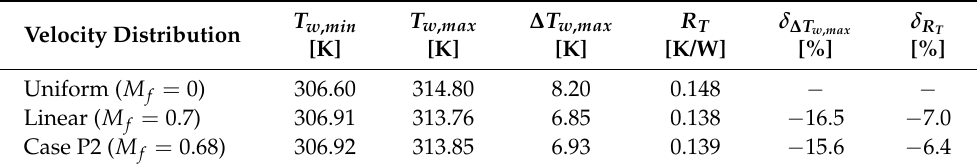
Table 4. Sample thermal performance of the MCHS for different microchannels velocity distributions and u ave = 1.0